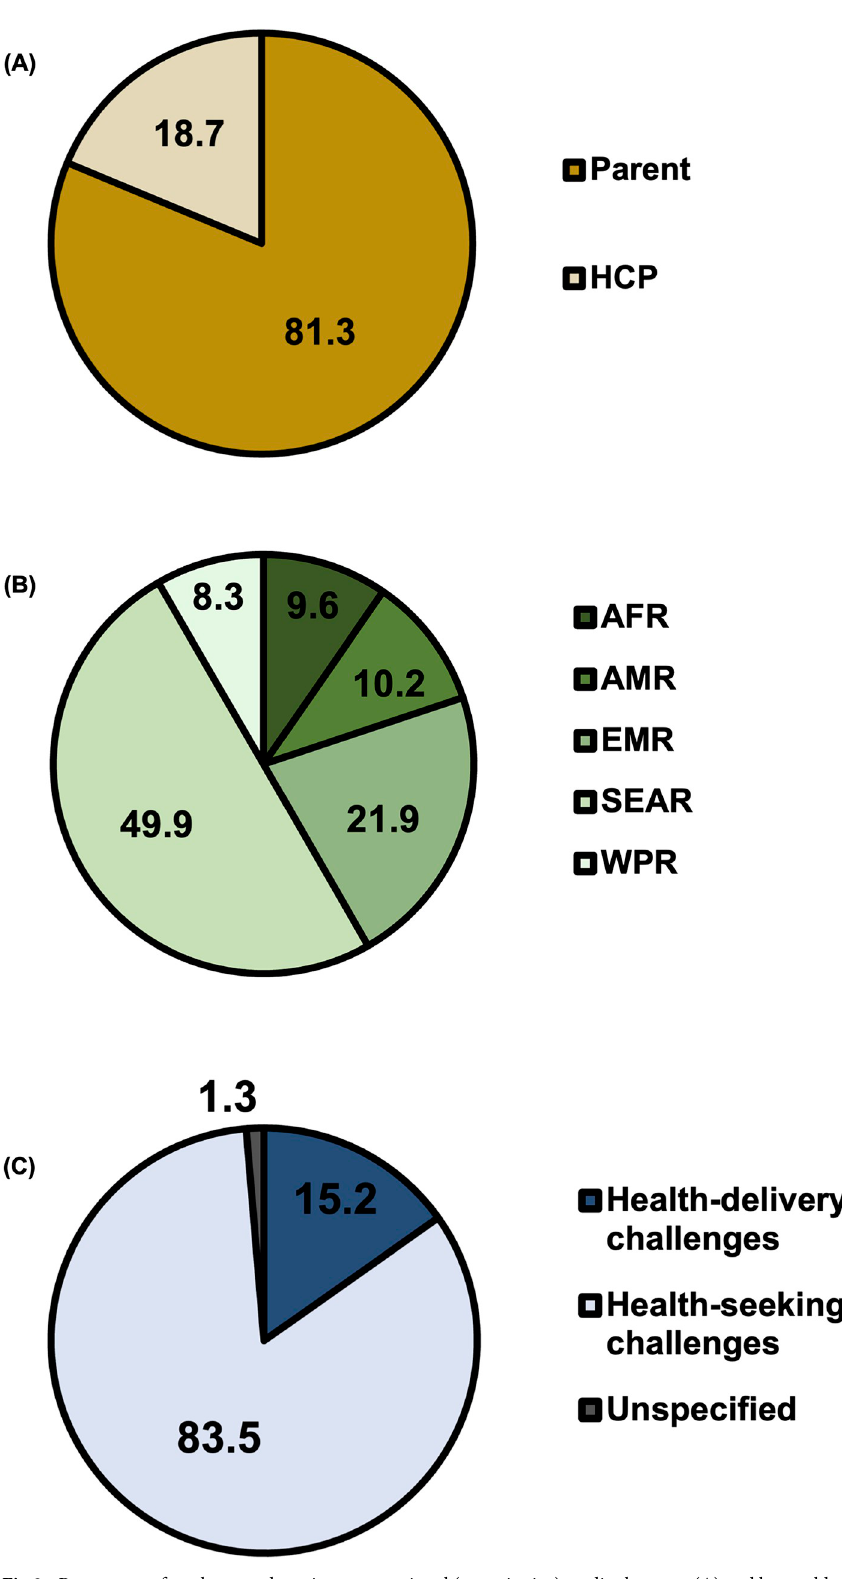
Fig 3. Percentage of total respondents in cross-sectional (quantitative) studies by actor (A) and by world region (B); n = 2,853. Percentage of total responses by healthcare-seeking and healthcare-delivery issues (C); n = 3,160. https://doi.org/10.1371/journal.pgph.0001415.g003 PLOS Global PublicHealth | https://doi.org/10.1371/journal.pgph.0001415 January24,